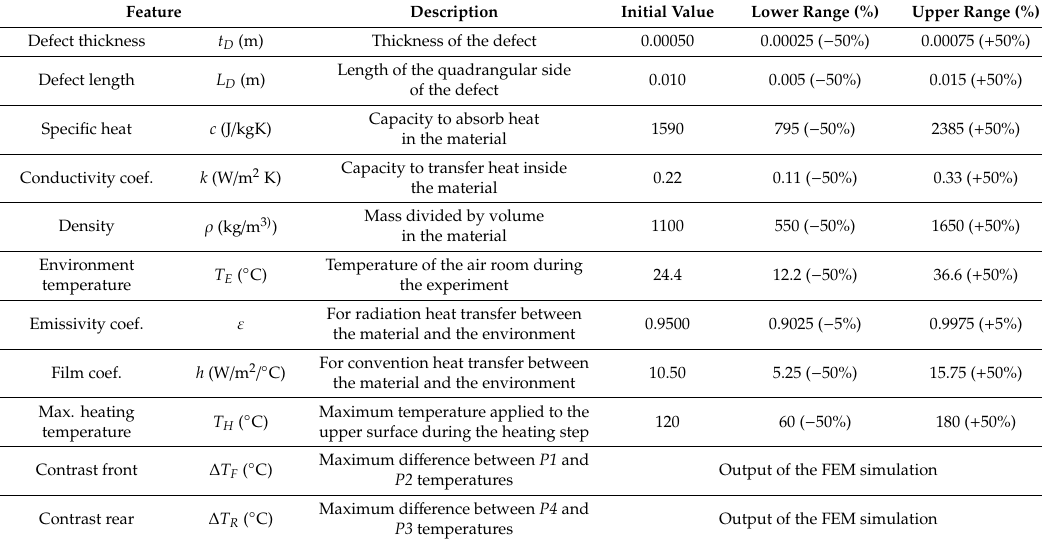
Table 1. Material properties correspond to Nylon PA-12 [7]. Ranges of variation of the input variables are in absolute values and